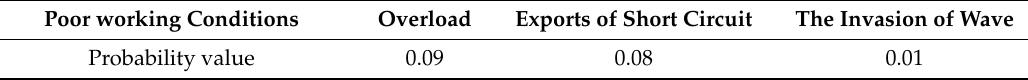
Table 1. Probability of adverse working